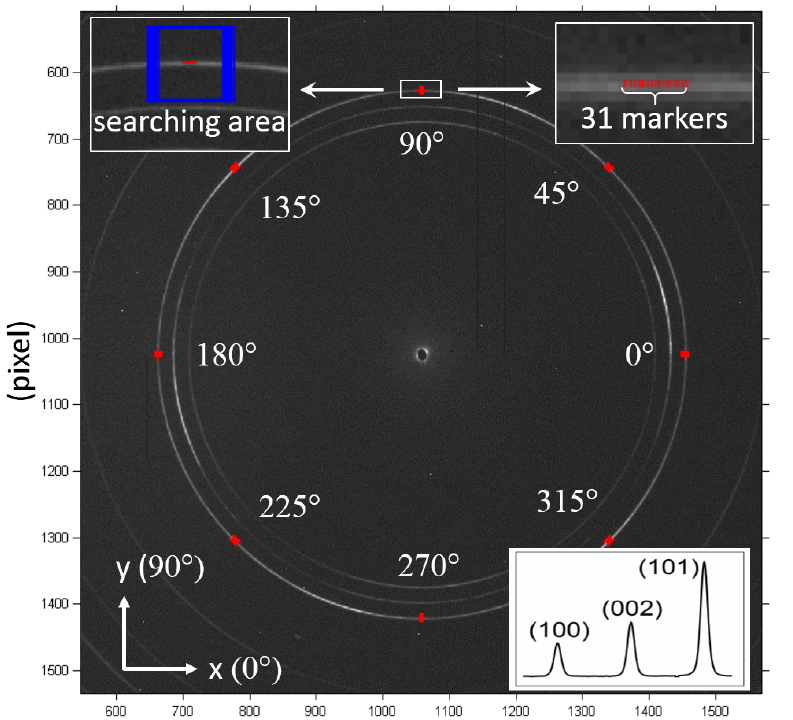
Figure 3. DIC setup illustrated for the base image with markers placed at different azimuthal angles on the (101) diffraction ring. The markers and searching area for the 90 ◦ azimuthal angle are shown at a higher magnification in the figure inserts as an